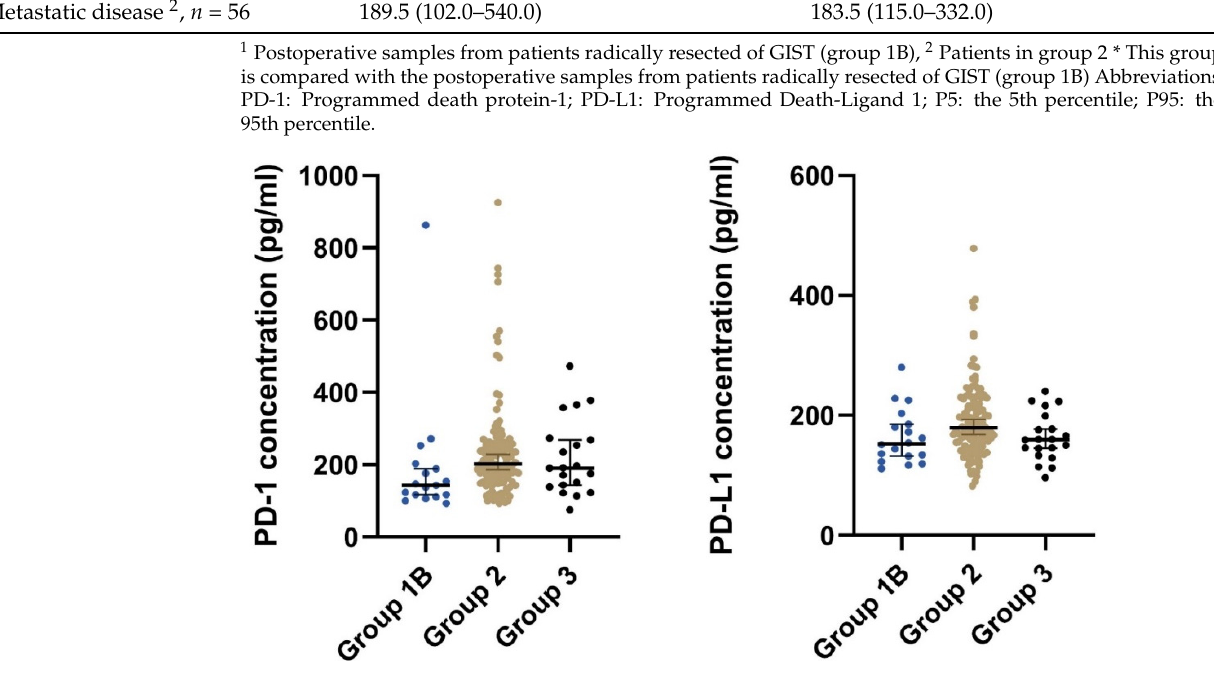
Figure 2. The plot visualizes the plasma concentration of PD-1 and PD-L1 in the group of postoperative samples from patients that had undergone radical surgery (group 1B) and the group of patients with local, locally advanced, or metastatic GIST (group 2). The horizontal lines mark the median values in the two groups. Abbreviations: PD-1: Programmed death protein-1; PD-L1: Programmed Death-Ligand 1. Table 3. Univariate and multivariate analysis of the plasma PD-1 and PD-L1 concentrations * at the time of inclusion for patients with GIST (group